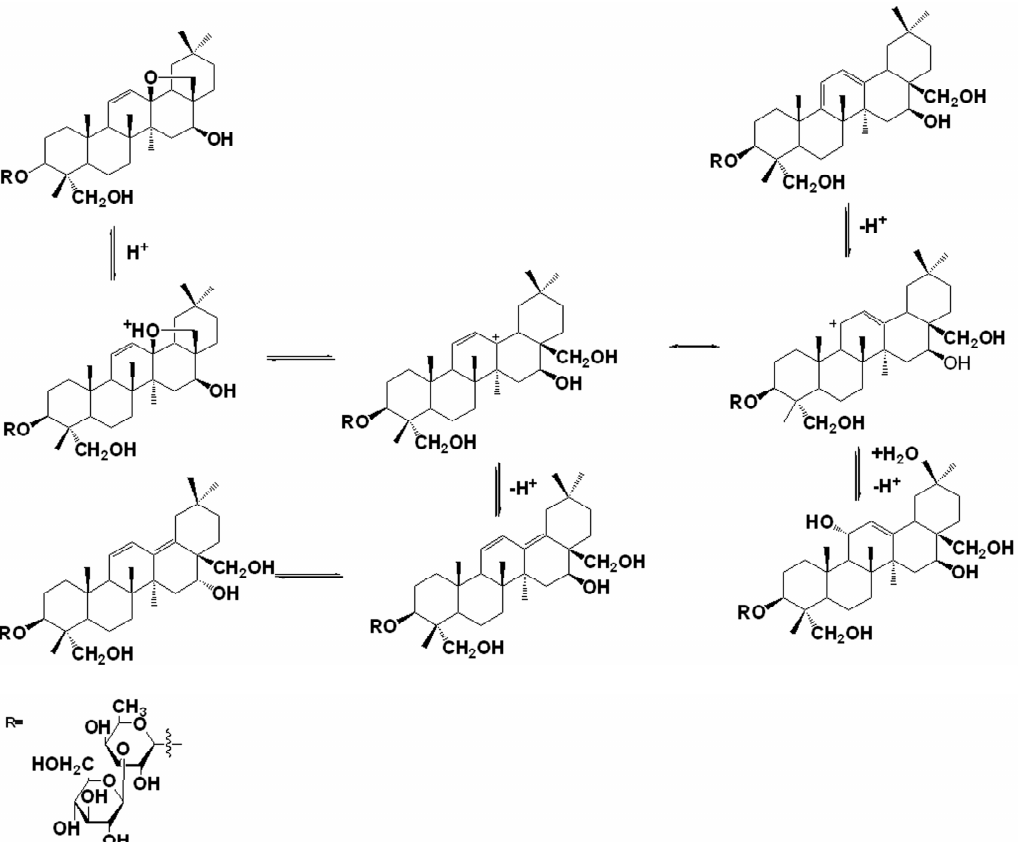
Figure 6. Structural transformation map of saikosaponin A under the stress of acid hydrolytic conditions.